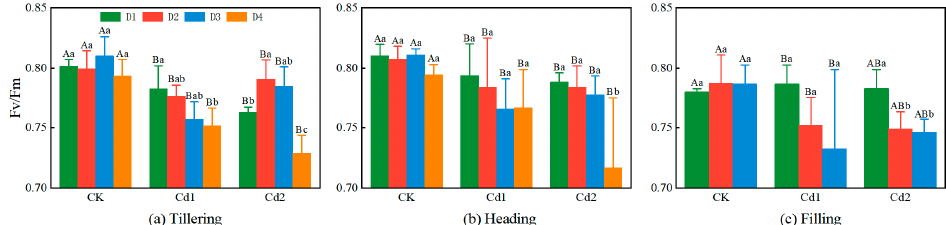
Figure 8. Effect of different cadmium stress concentrations on Fv/Fm of rice canopy leaves at different leaf positions during different growth stages (( a ) Tillering; ( b ) Heading; ( c ) Filling). Uppercase letters indicate significant differences between CK, Cd1, and Cd2, and lowercase letters indicate significant differences between D1, D2, D3, and D4.